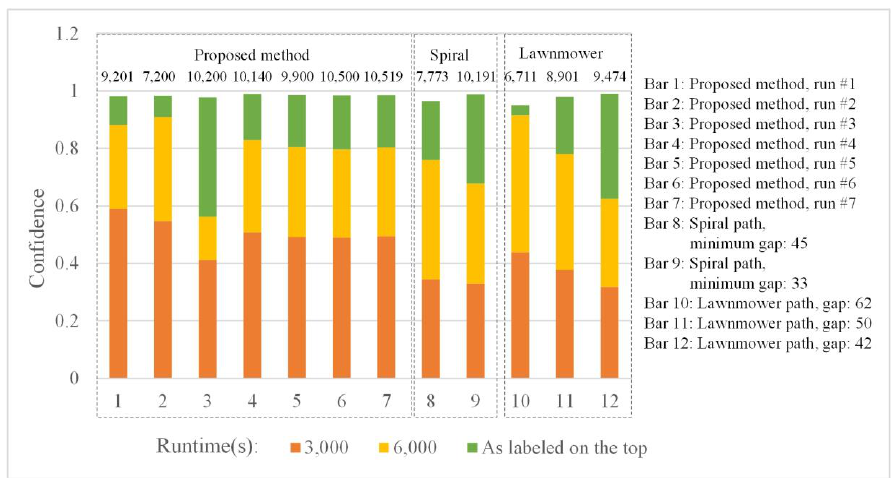
Figure 11 Figure 10. Coverage capabilities of different strategies and parameters.